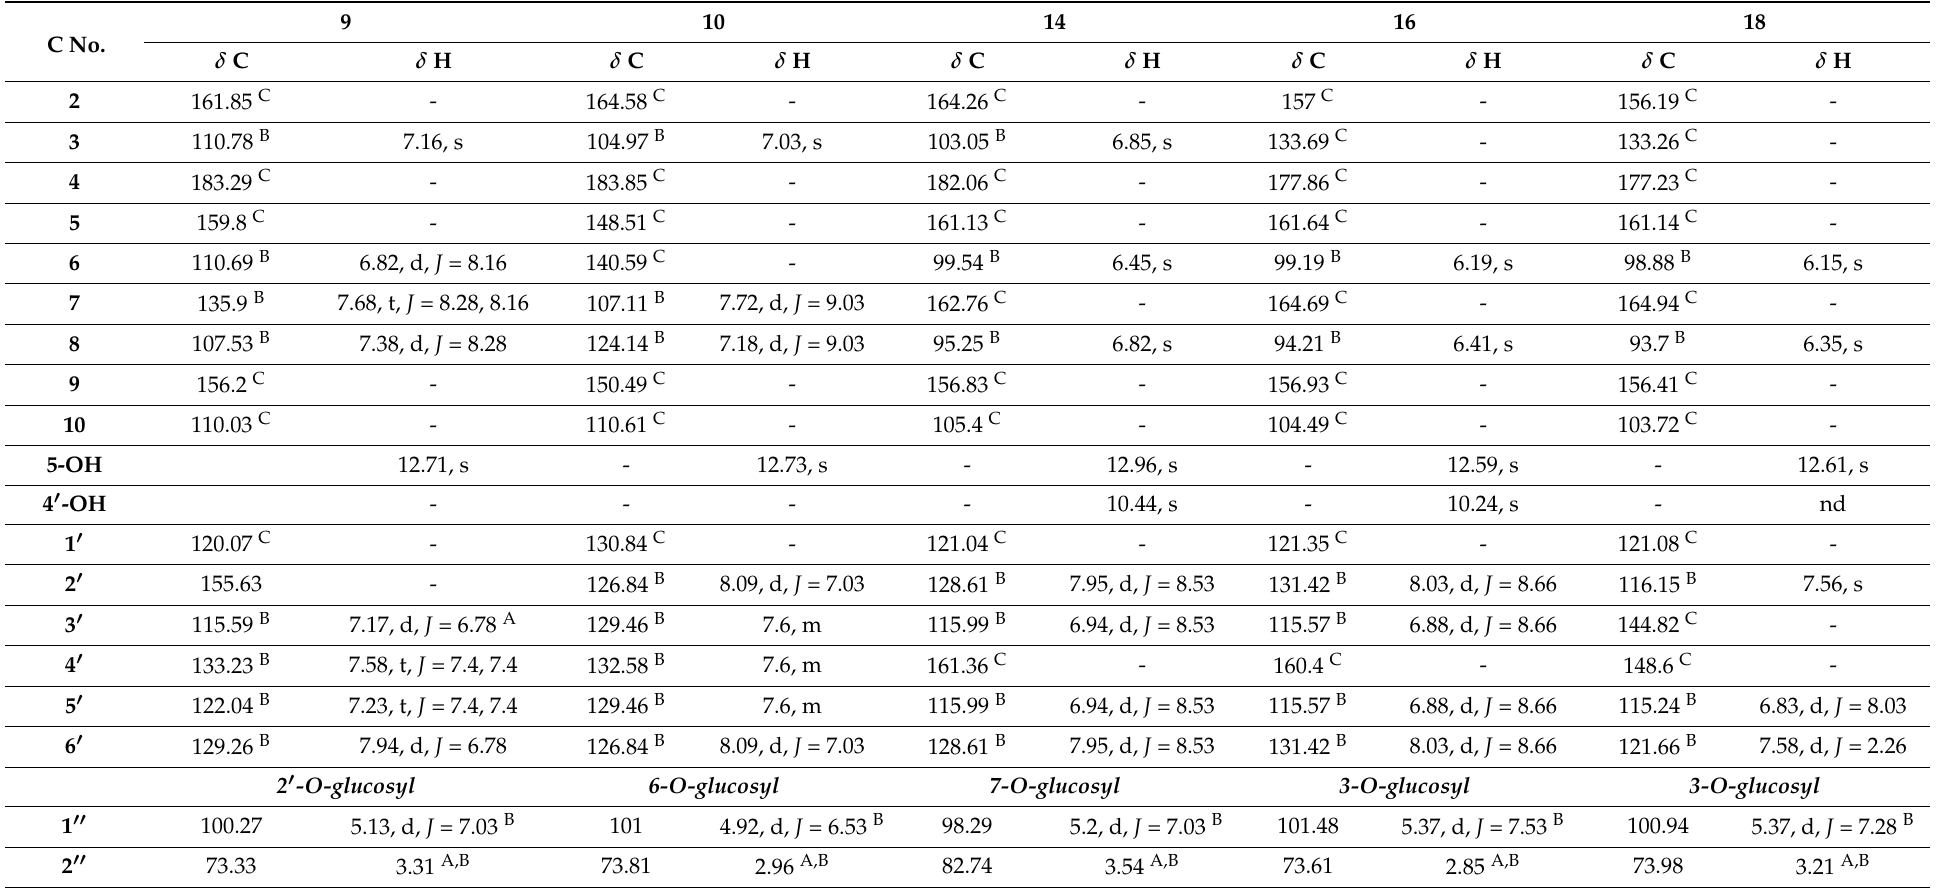
Table 1. The 13 C and 1 H spectral data of compounds 9, 10, 14, 16, and 18 (400 MHz for 1 H and 100 MHz for the 13 C spectrum; δ in ppm , J in Hz , DMSO- d